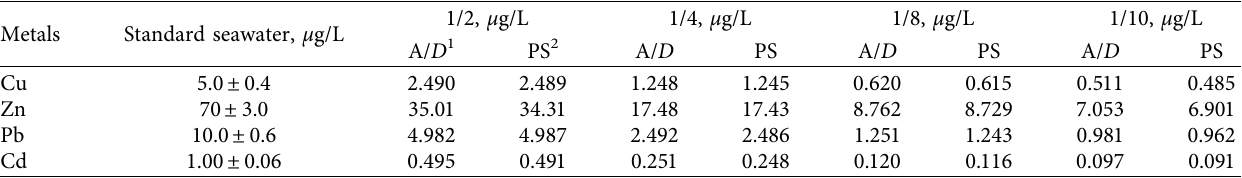
Table 3: Diluted standard